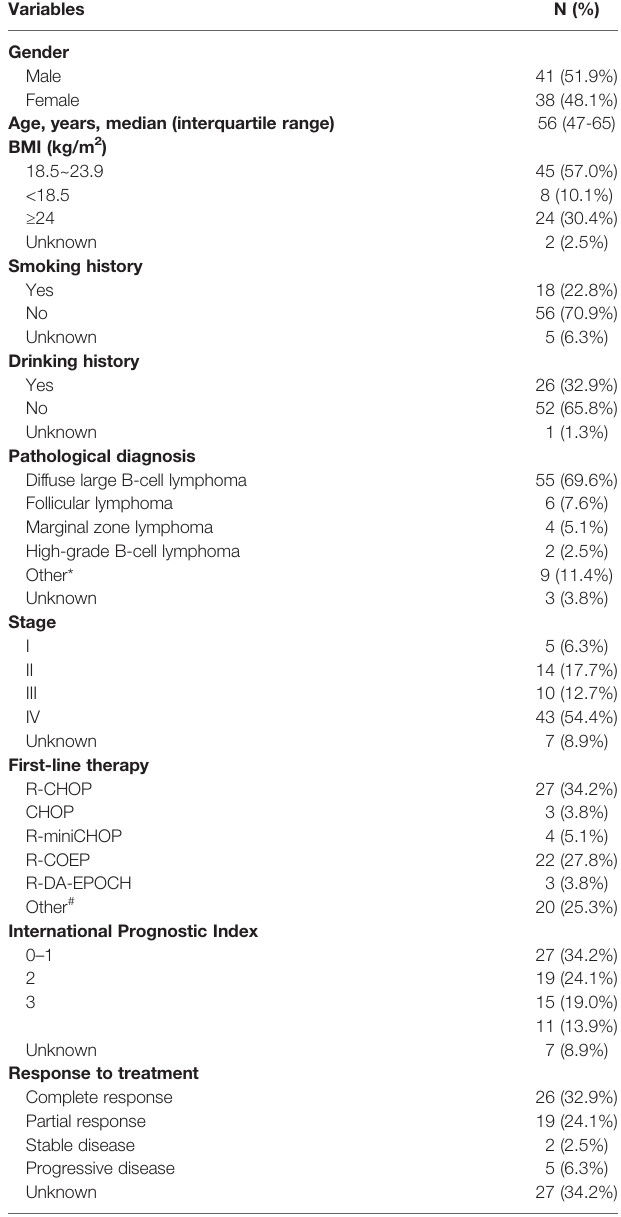
TABLE 1 | Patient demographic and clinical characteristics